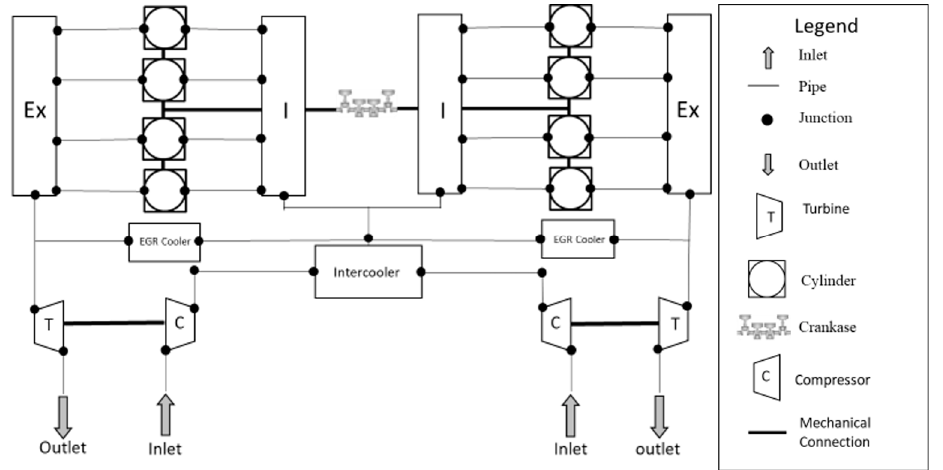
Figure 5. Simplified 1D scheme of HD Diesel Engine.